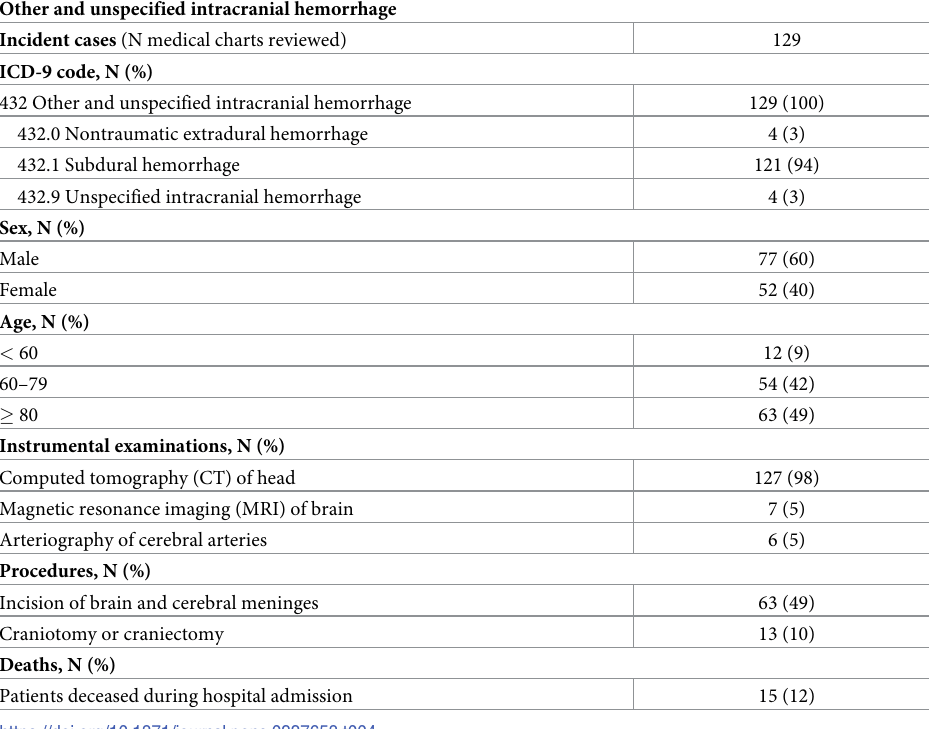
Table 4. Characteristics of patients with other and unspecified intracranial hemorrhage who were identified in the Regional Administrative Database of Umbria. Other and unspecified intracranial